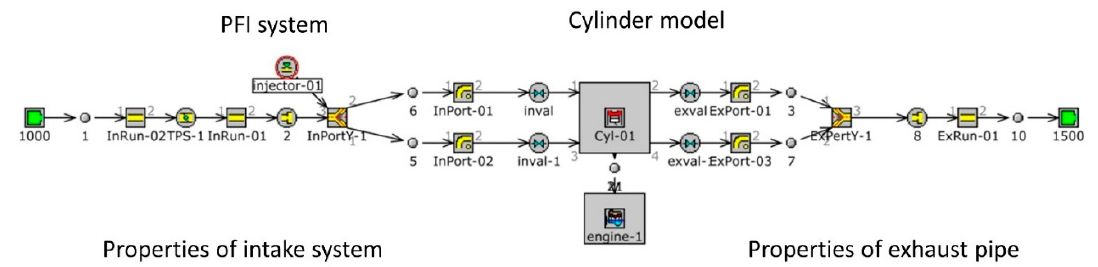
Figure 2. Single-cylinder engine mode.